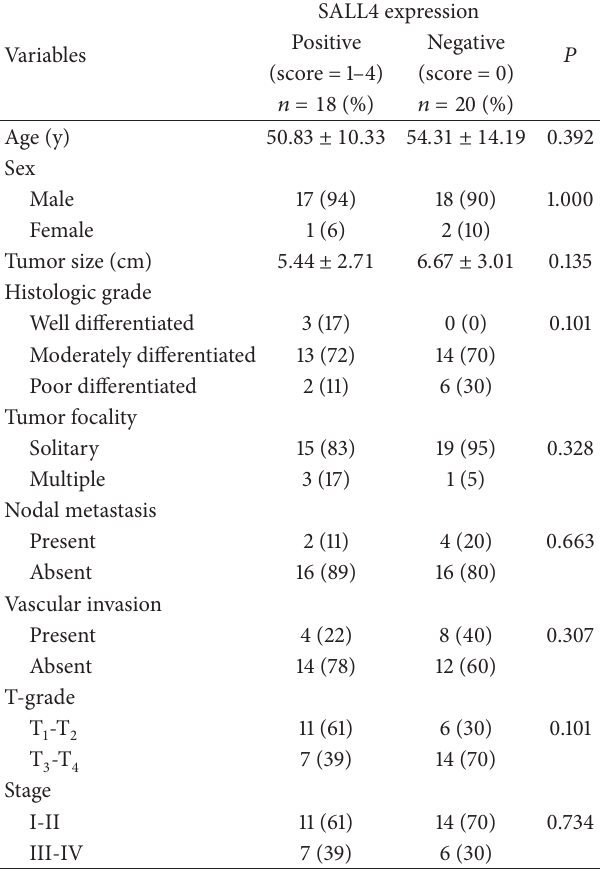
Table 2: Association between SALL4 expression and clinicopatho- logic characteristics in HCC.